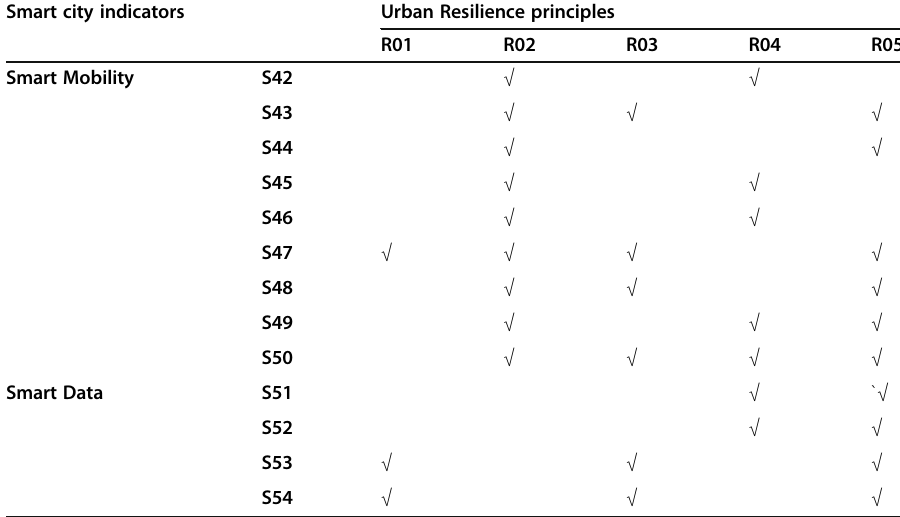
Table 6 Mapping relationship between smart cities indicators and principles of urban resilience (Authors)